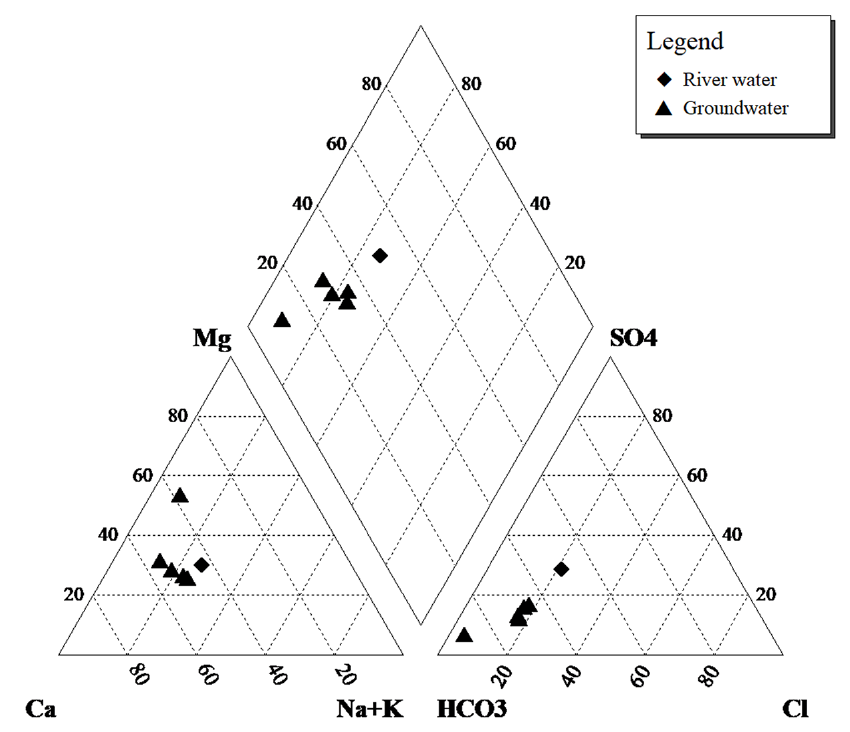
Figure 3. Piper diagram of river water and groundwater samples.